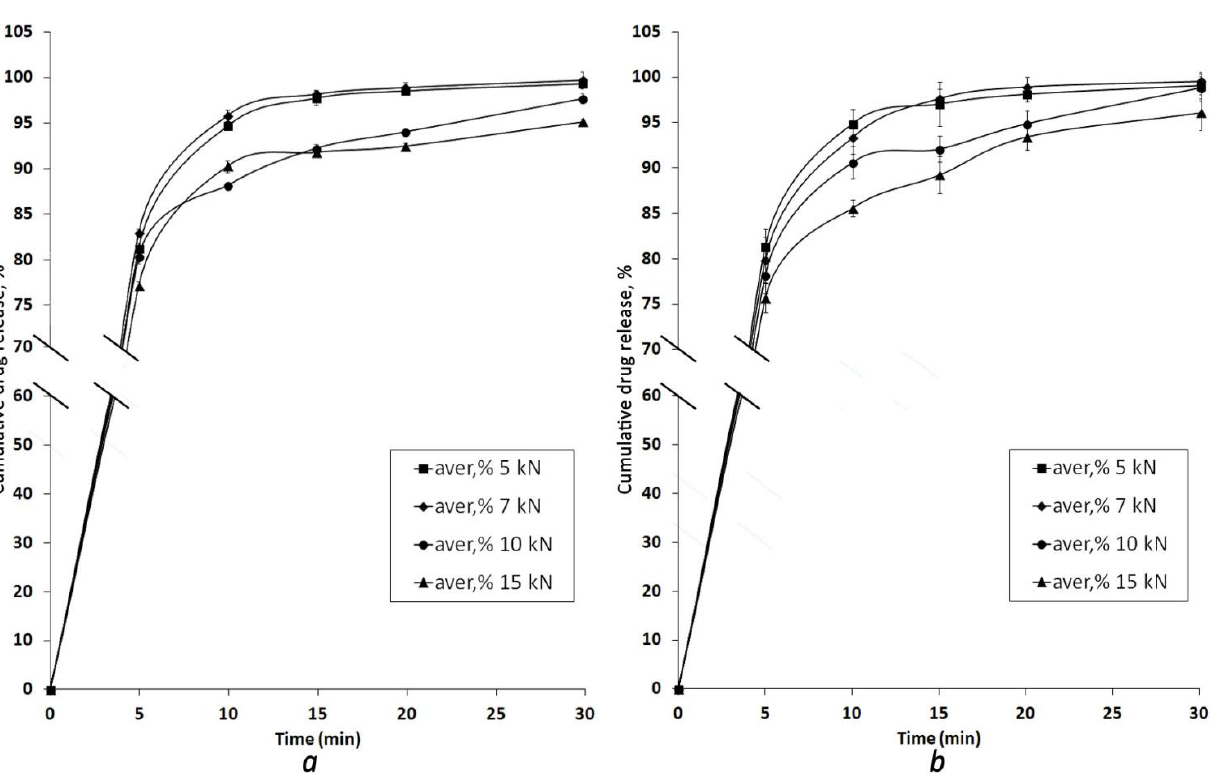
Figure 3. Cumulative release of LH ( a ) and AsA ( b ) from four batches of MCGs compressed at different compression forces (values are expressed as mean ± SD, n = 6, p < 0.05). Table 3. Kinetics of APIs release depending on